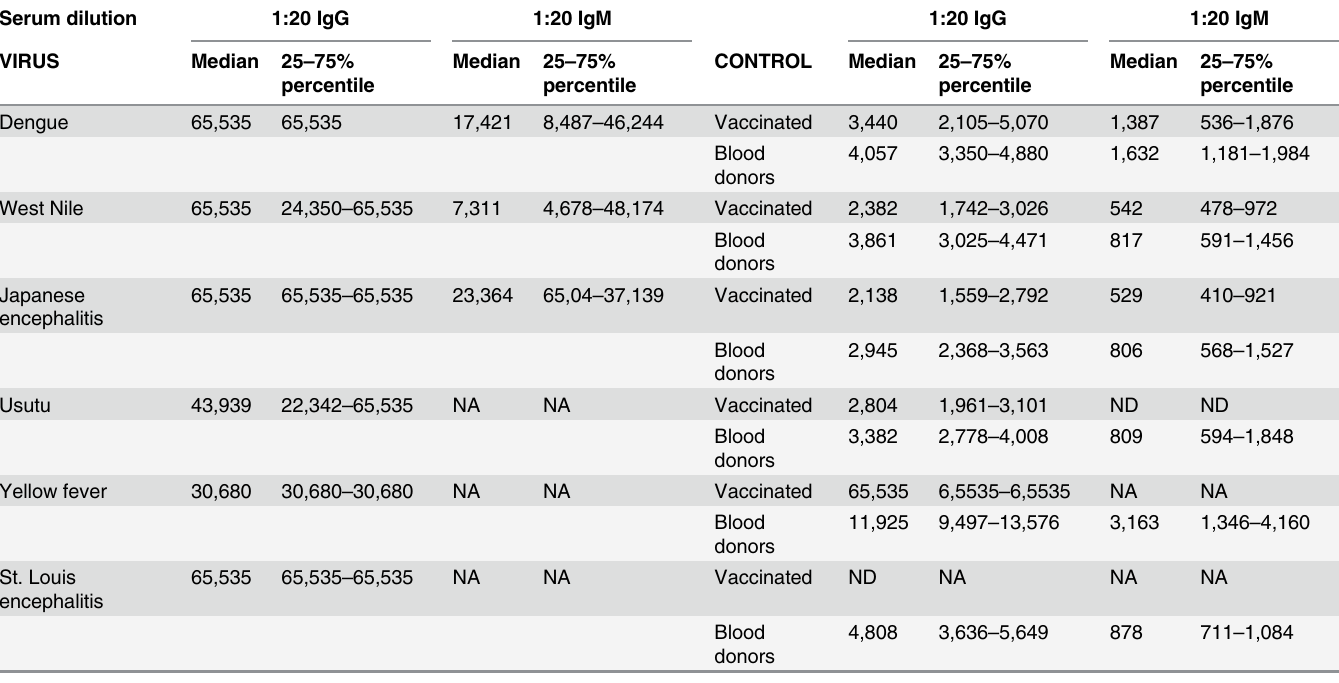
Table 2. Median signal and 25 – 75% percentile for IgG and IgM per virus antigen test group. Serum dilution